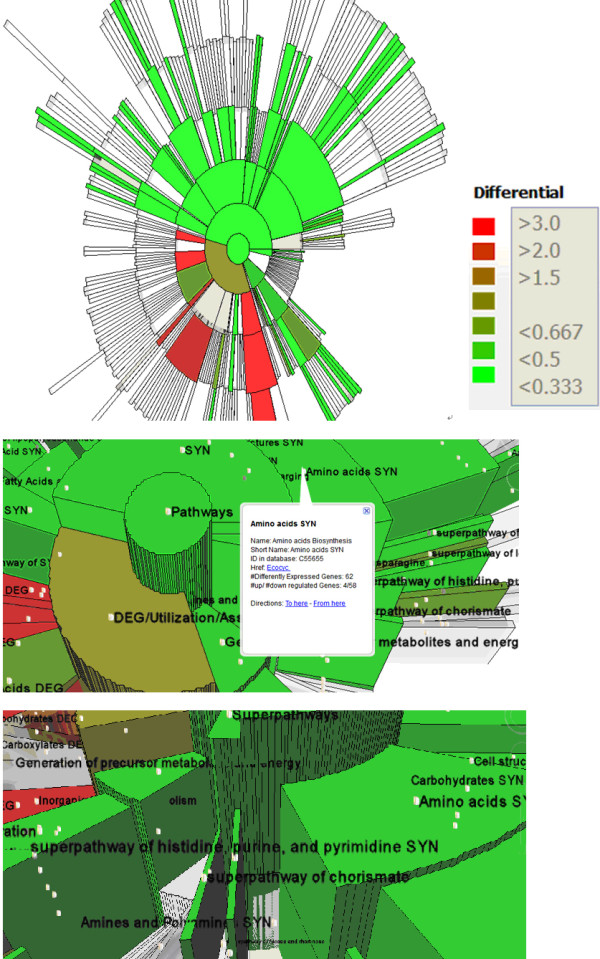
Differentially expressed genes mapped on the pathway ontology. Color indicates the ratio of up/down regulated genes; height shows the log value of total number of differentially expressed genes. Most of the upper side of ontology categories is down-regulated, while some categories on the lower-left side are up-regulated. Zoomed in view (center) shows the detail of amino acids biosynthesis. (bottom) shows that two superpathways (histidine, purine, and pyrimidine biosynthesis, and chorismate) have many more genes differentially expressed downward than other superpathways.